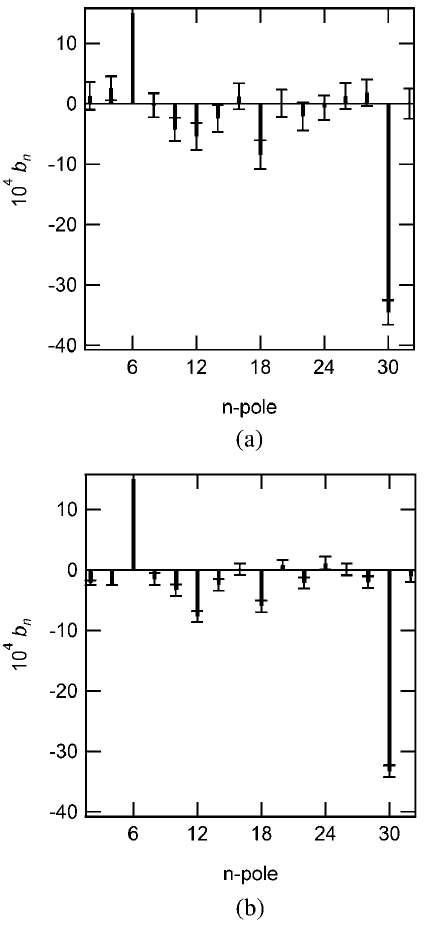
FIG. 15. Measured normal multipole content of a sextupole magnet: (a) circular trajectory; (b) 6PCT. The sextupole compo- nent has been normalized to